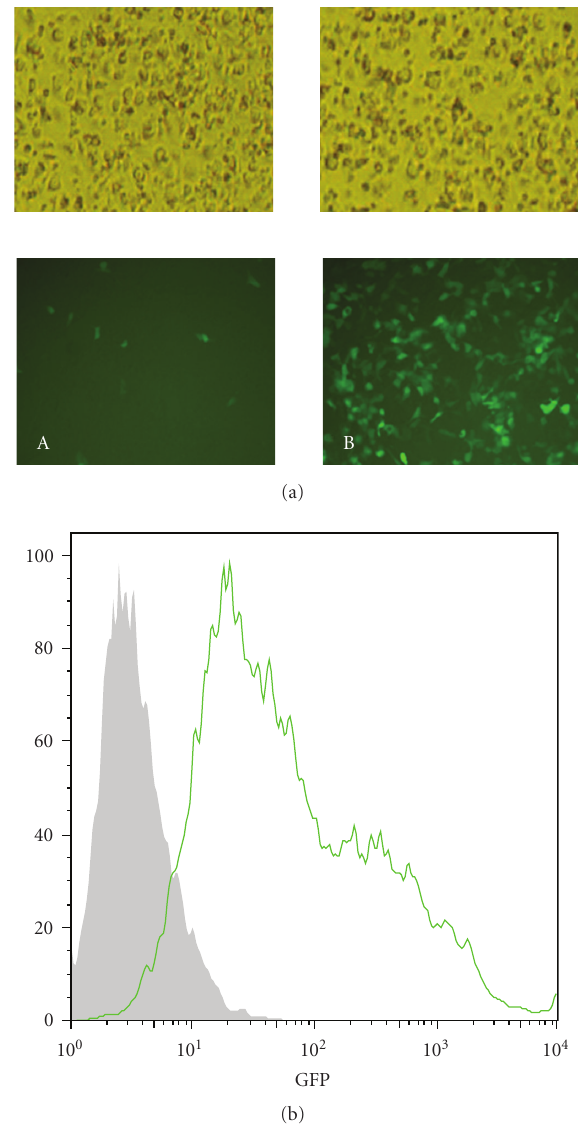
Figure 2: Transduction e ffi ciency was estimated 4 days after transduction at indicated MOIs. (a) GFP expression was observed under light microscopy (top) or fluorescence microscopy (bottom). (A) MOI of 5 ( × 100). (B) MOI of 20 ( × 100). DCs saw an increase in expression of GFP that peaked when MOI = 20. (b) The e ffi ciency of infection was determined by assaying GFP expression by flow cytometry (green line) and comparing with uninfected control cells (grey